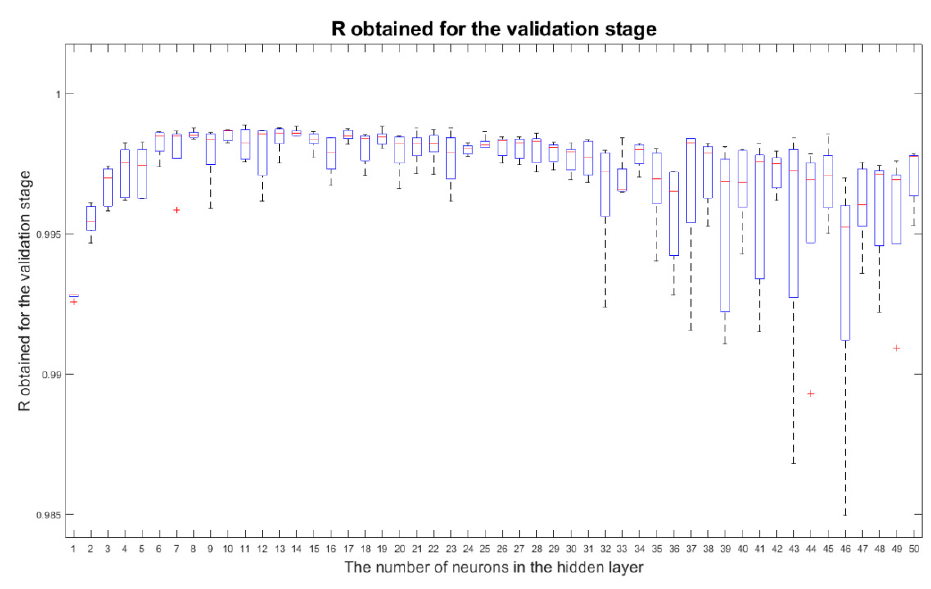
Figure 5. The Pearson’s coefficient ( R) obtained for the neural network structure with a certain number of neurons in a hidden layer—results for the validation stage.